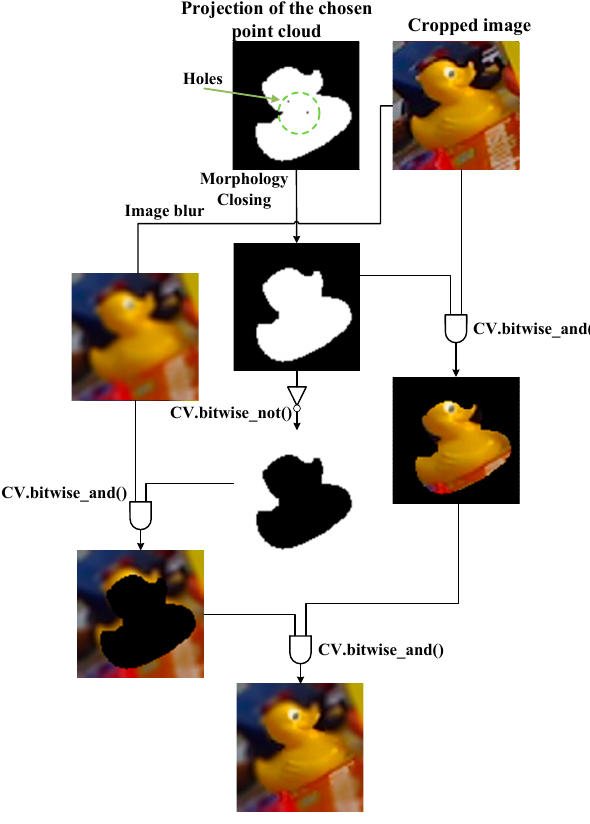
Figure 3. The process of image modification.